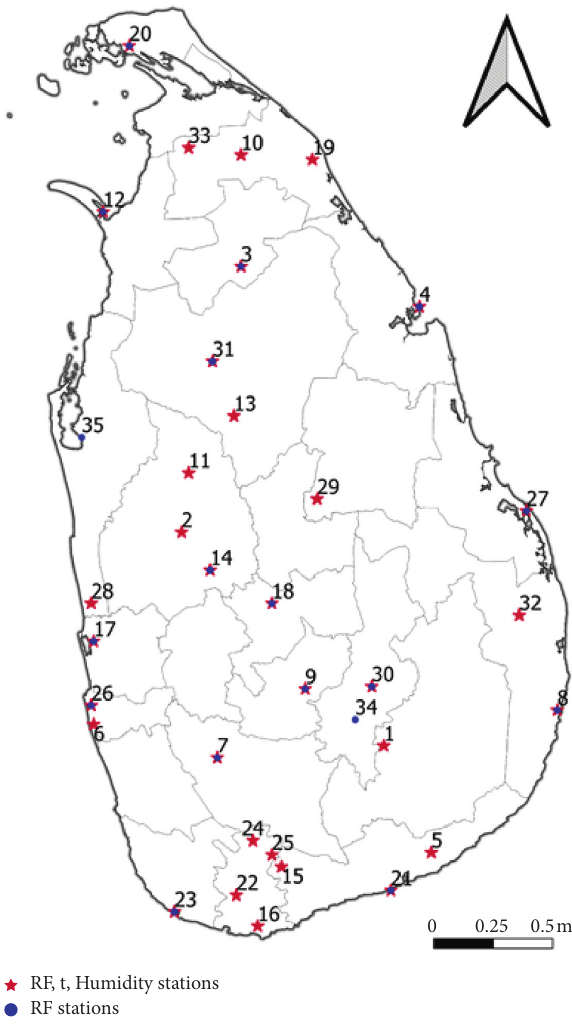
Figure 1: Meteorological stations used for the